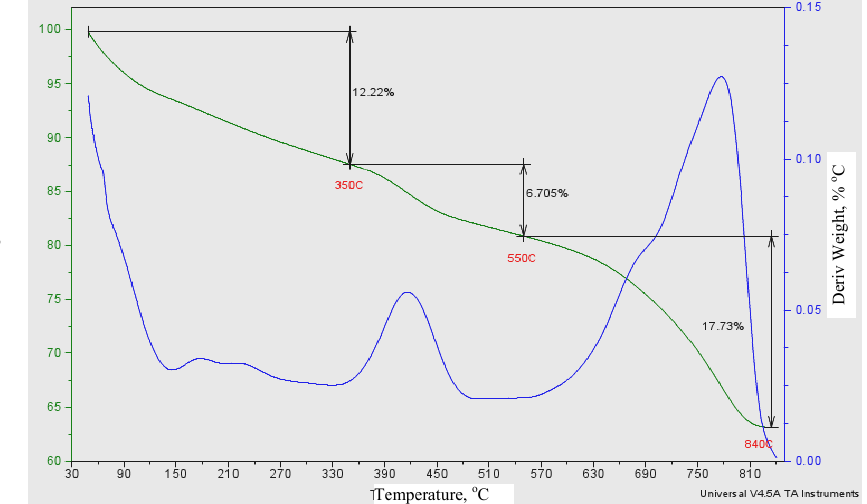
Figure 5. TG-DTG of BF 20 0 C min -1